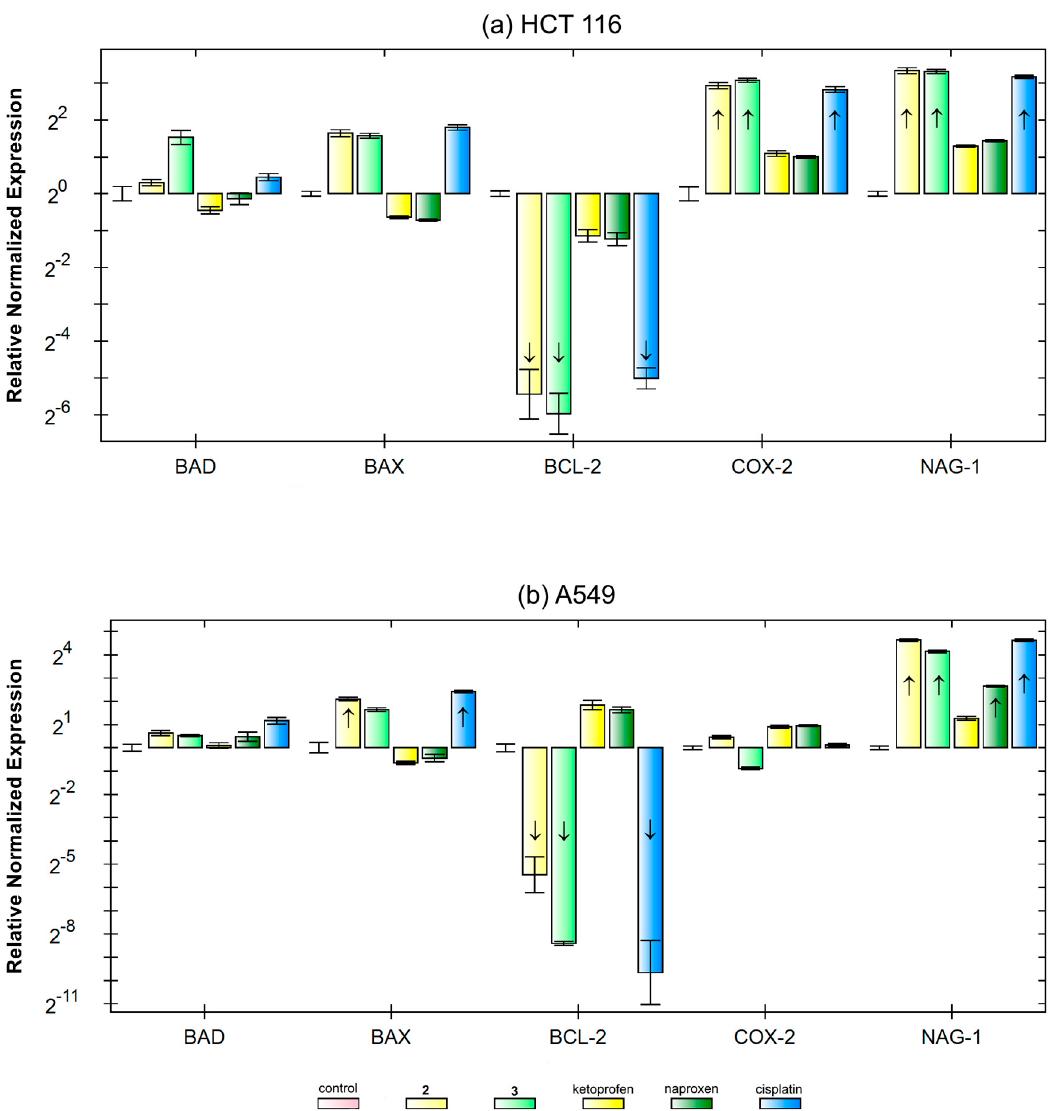
Figure 7. Relative gene expression of BAD (pro-apoptotic), BAX (pro-apoptotic), BCL-2 (anti-apoptotic), COX-2 (cyclooxygenase-2), and NAG-1 (NSAID-activated gene 1) in ( a ) HCT 116 (lower COX-2 expression) and ( b ) A-549 (higher COX-2 expression) cells following equitoxic 24 h treatments (IC 50 ) with cisplatin, 2 , 3 , ketoprofen, and naproxen. From the left to right of each sequence: Control, 2 (light yellow), 3 (light green), ketoprofen (dark yellow), naproxen (dark green), and cisplatin (light blue). The RT-qPCR experiment was performed in triplicate, and the results were normalized to references genes in untreated control. The arrows indicate the upregulated (arrow up) or downregulated (arrow down) gene expression with respect to internal threshold value as determined by the CFX Manager software.